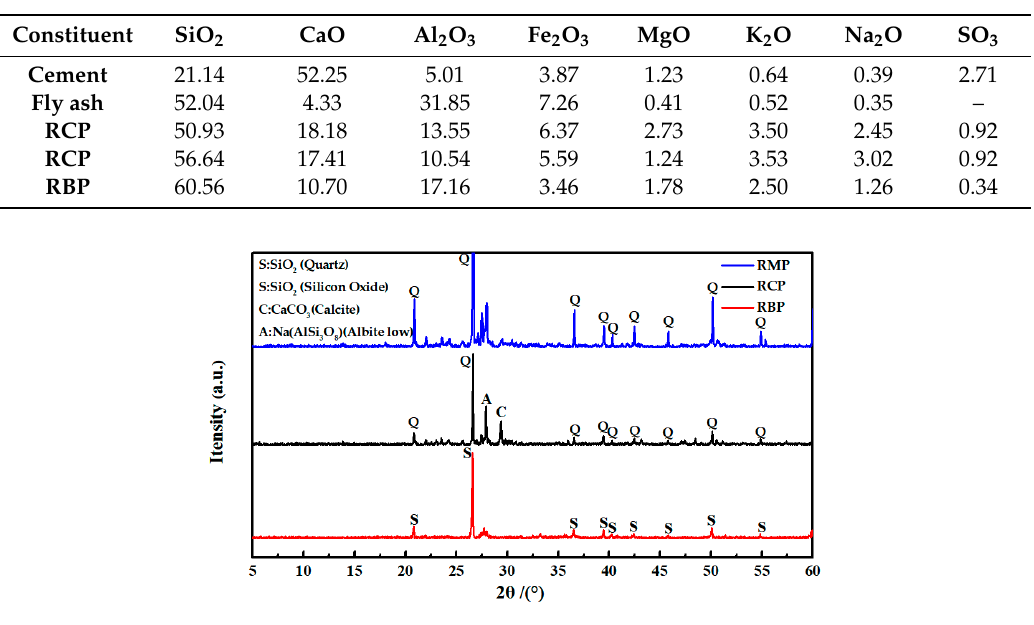
Figure 6. The XRD patterns of various RPs.